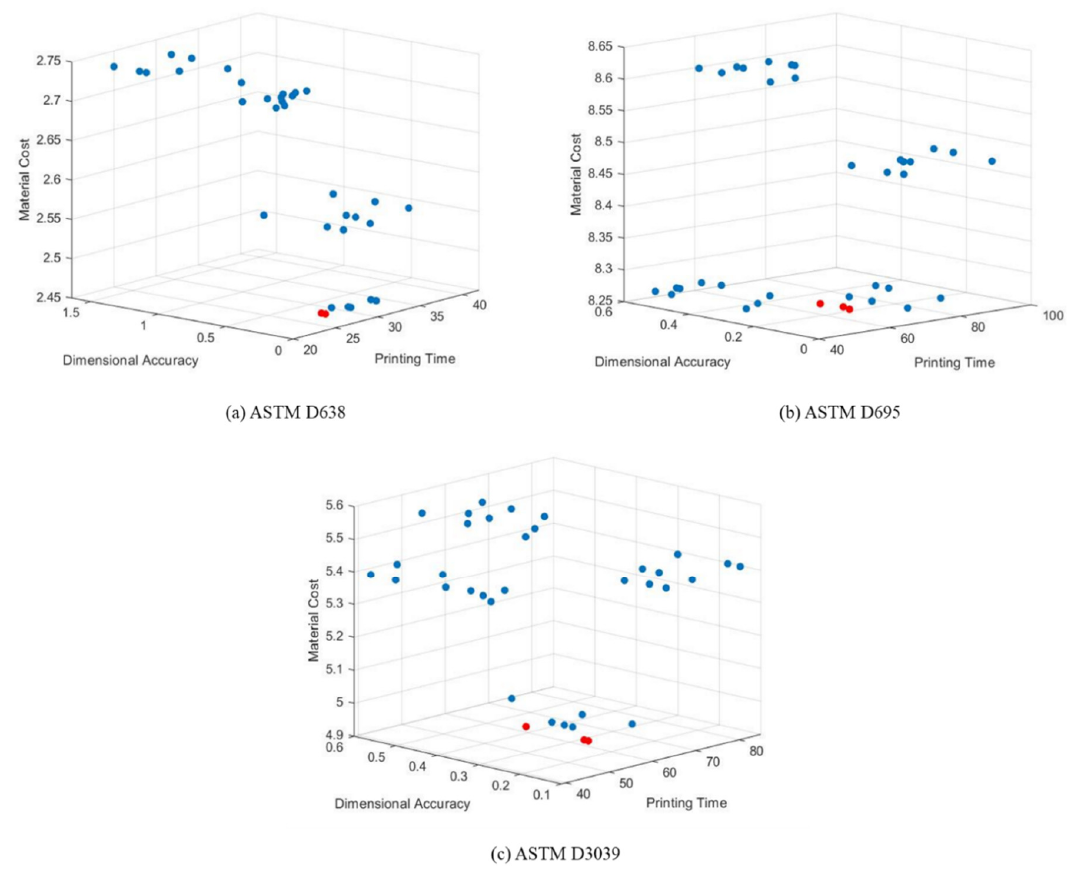
Figure 12. Optimal parameter settings (in red) for the overall manufacturing performance. ( a ) ASTM D638; ( b ) ASTM D695; ( c ) ASTM D3039.